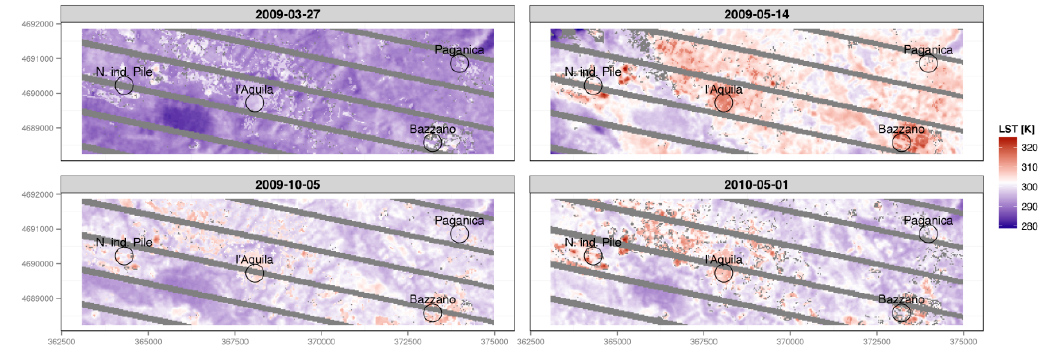
Figure 8. Land Surface Temperature Maps (LST) without rescale. The gray pixels correspond to the SCL-off and cloud cover assessment masks. Images are around 12 km in width.